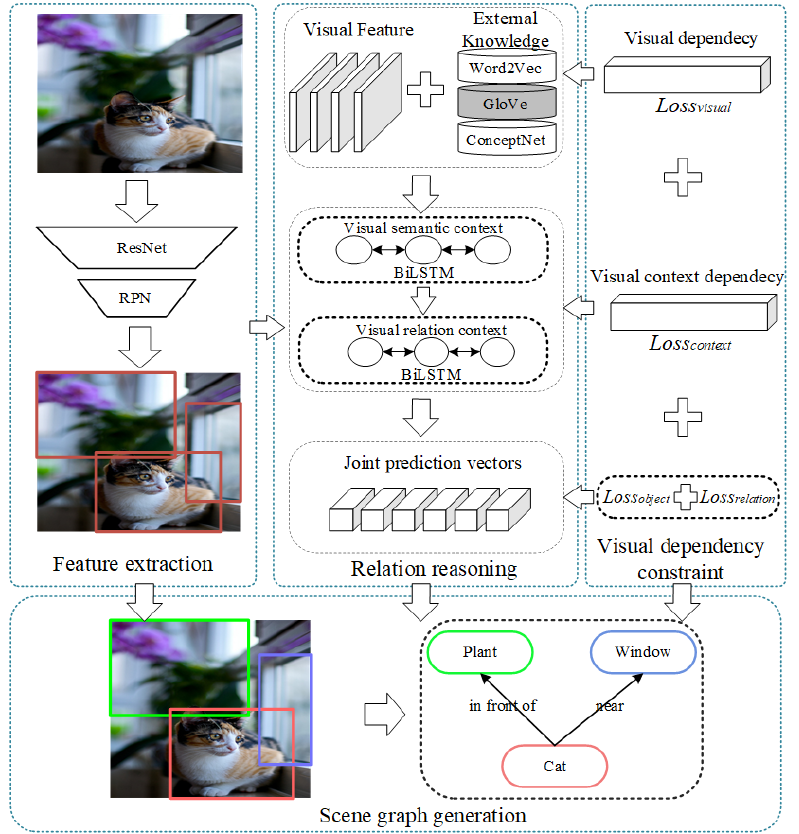
Figure 2. Overview of our proposed modules. First, the feature-extraction module extracts visual features in the images. Then, the relational reasoning module combines external knowledge and visual features to obtain the global contextual information. Finally, the visual dependency constraint module reduces visual dependencies in the